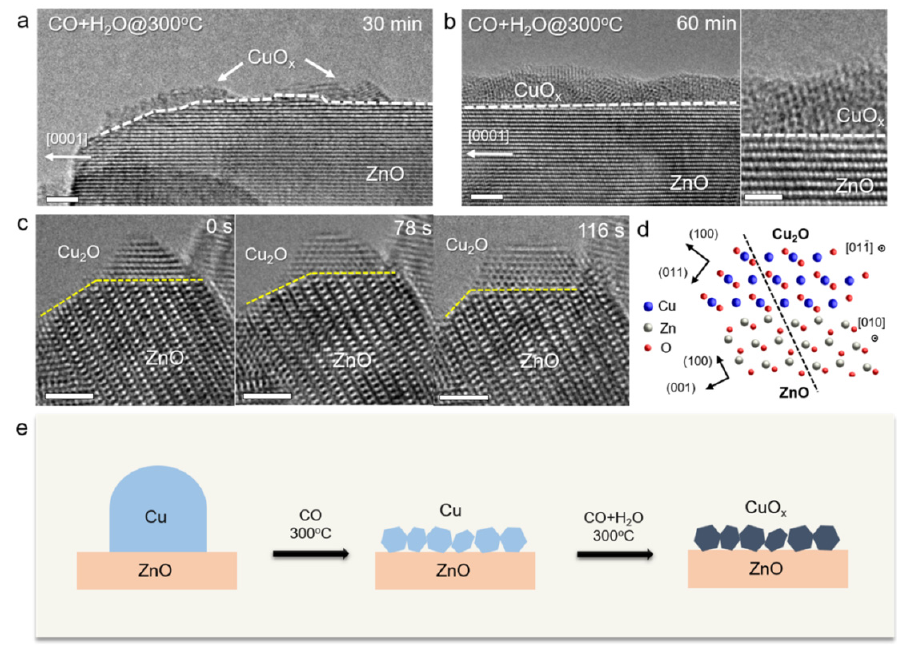
Figure 7. Wetting and reforming of Cu species on ZnO under a CO + H 2 O gas mixture. ( a ) HRTEM image of the ZnO surface wet with disordered CuOx nanoislands after a 30 min exposure to the CO + H 2 O (1:1) gas mixture. ( b ) HRTEM image shows an overlayer of CuOx species on ZnO with a thickness of ∼ 2 nm after a 60 min exposure to the same gas mixture. ( c ) A series of time-resolved HRTEM images depicts the growth process of the Cu 2 O nanoparticle on a terrace of the ZnO surface. ( d ) Atomic model of Cu 2 O and ZnO forming an intimate interface at the atomic scale. ( e ) Schematic shows the structural evolution of Cu/ZnO under CO and CO + H 2 O treatment. All scale bars are 2 nm. Adapted from [61].